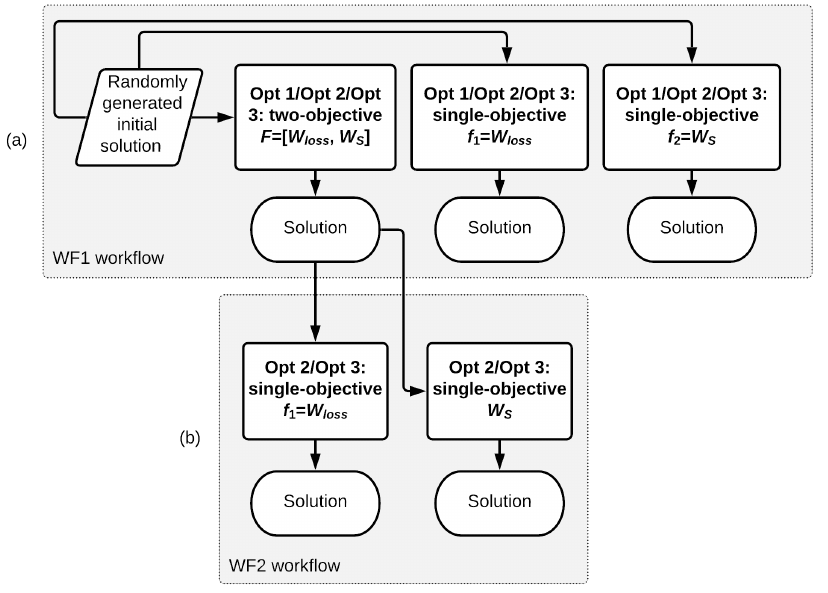
Figure 5. The workflows used in the research study, ( a ) workflow uses randomly generated input data for single and multi-objective optimizations; ( b ) workflow uses solution of the multi-objective optimization as input to single-objective optimizations.